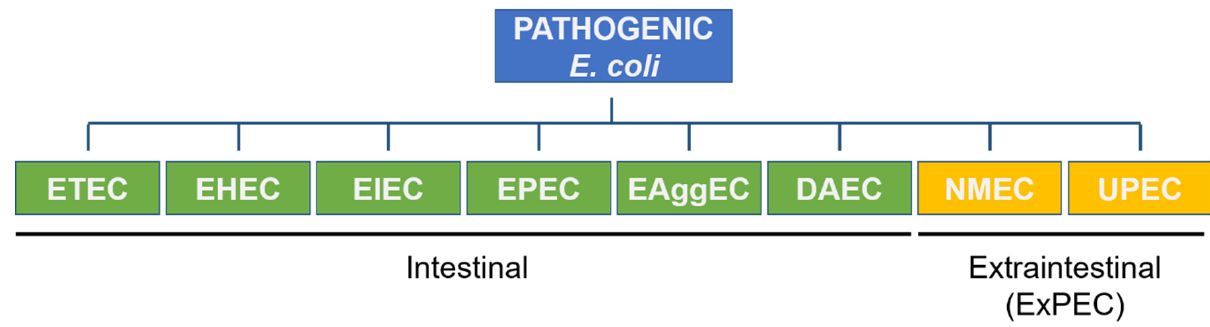
Figure 1. Pathogenic subtypes of E. coli . ETEC—Enterotoxigenic E. coli ; EHEC—Enterohaemor-